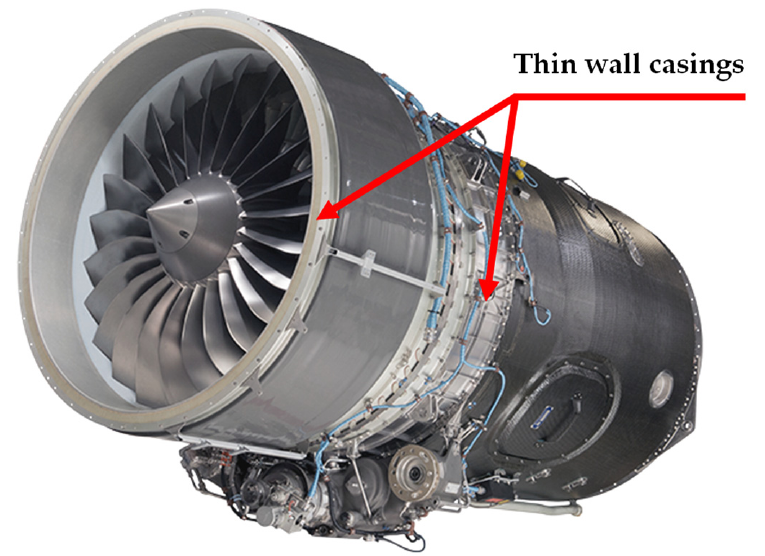
Figure 1. Example of new-generation jet engine with complex cases made from various grades of stainless steel, 17-4PH and 321 [8].